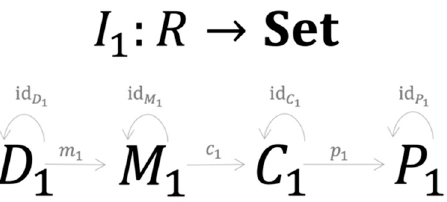
Figure 3. A specific credit risk model is a C - Instance of category 𝑅 .